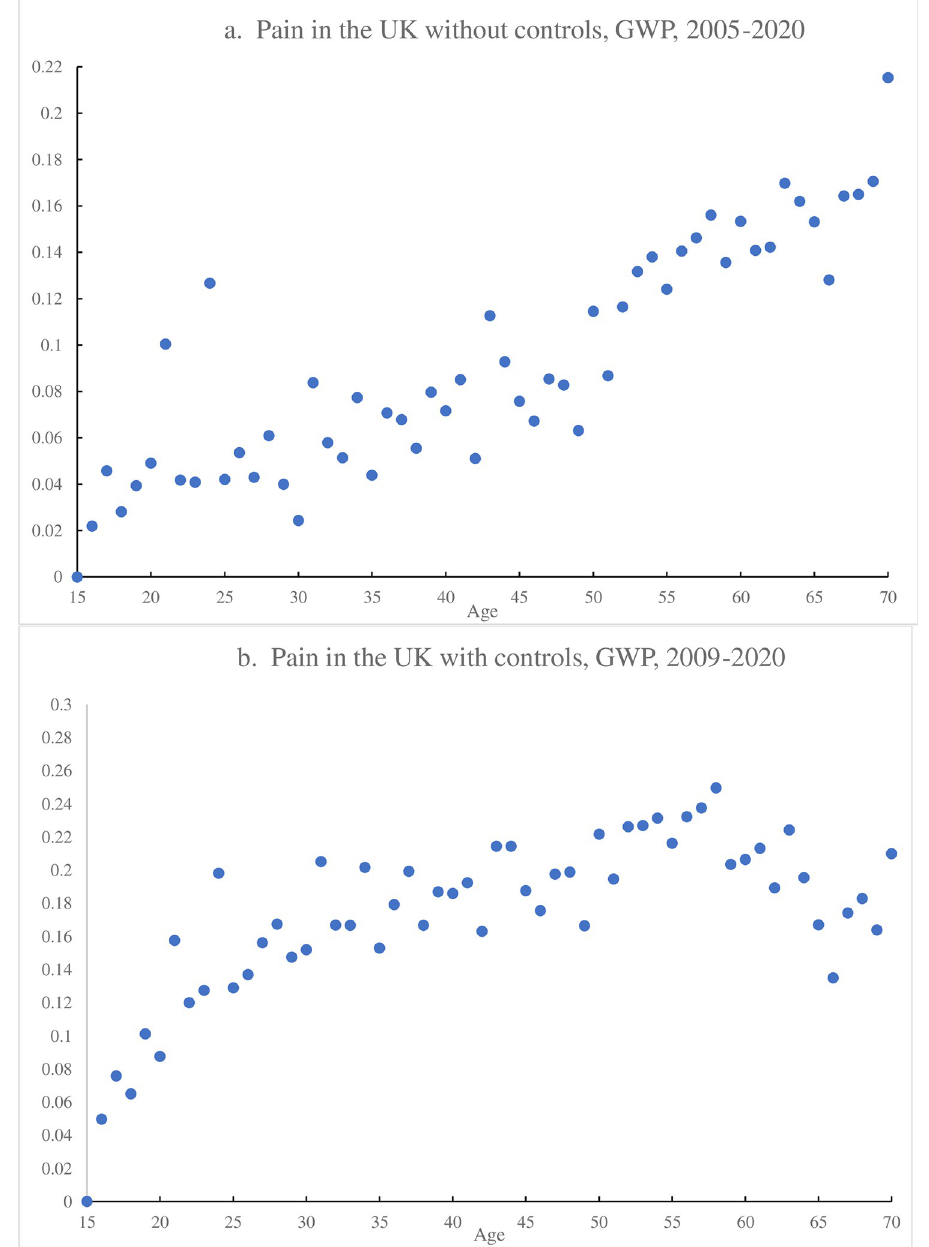
Fig 1. a. Pain in the UK without controls, GWP, 2005–2020. b. Pain in the UK with controls, GWP,